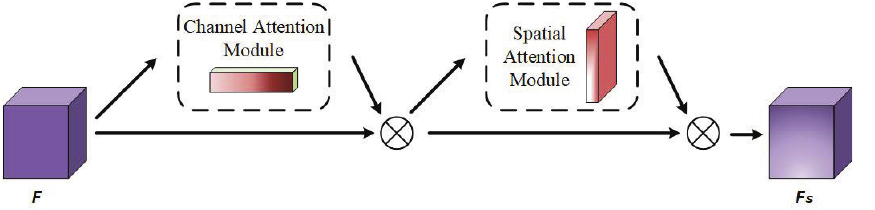
Figure 5. The structure of the convolutional block attention module (CBAM). It is composed of two sub-modules.